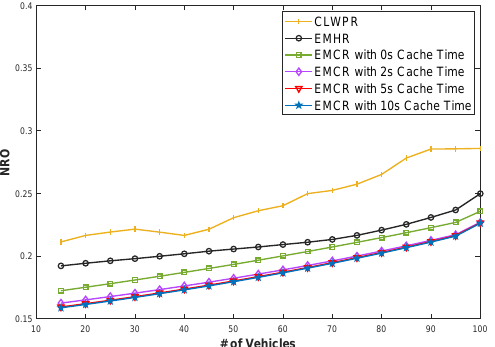
Figure 14. Normalized routing overhead vs. Number of Vehicles.